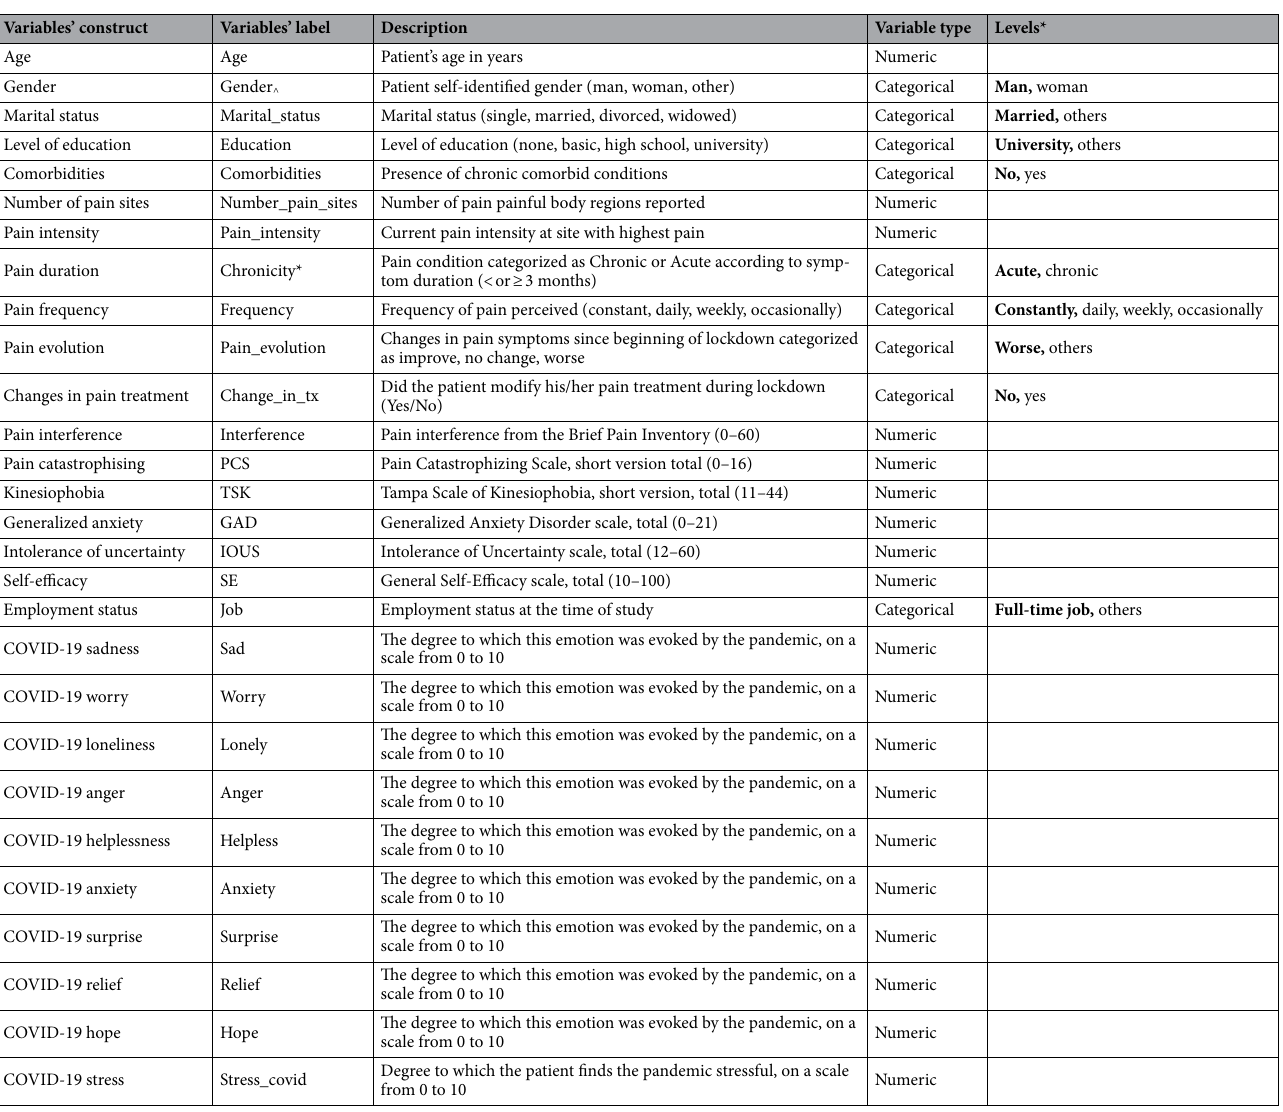
Table 1. Variables included in the network analysis. ^ Excluded from subgroup analysis between men and women. *Excluded from subgroup analysis between acute and chronic. Bold indicate reference